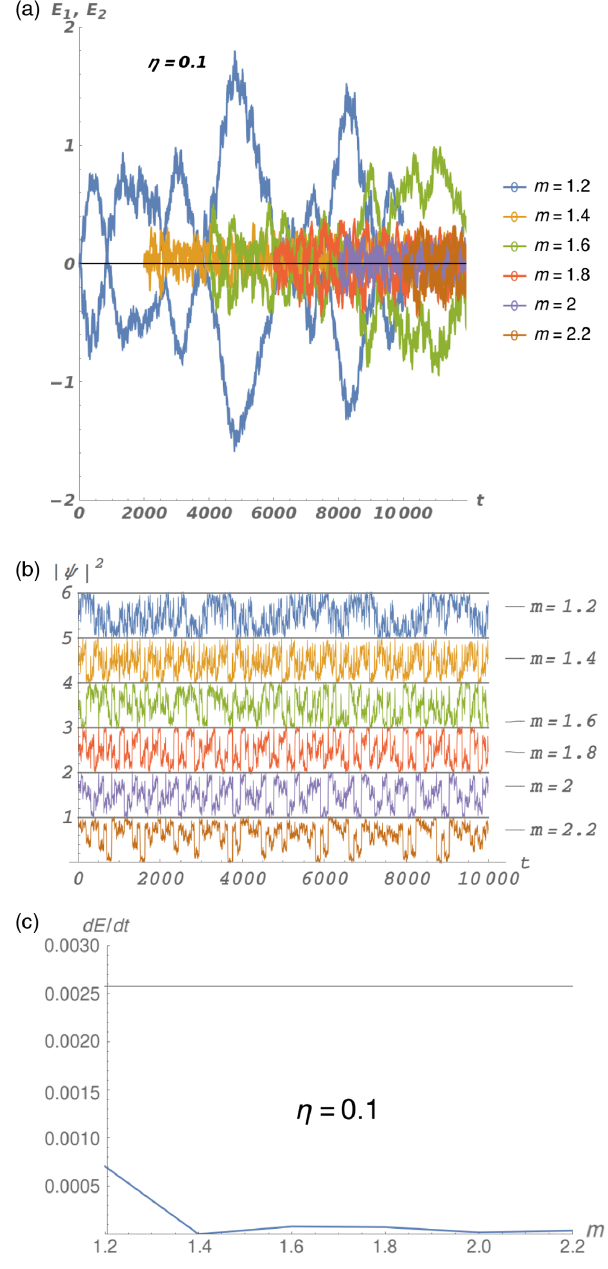
FIG. 15. Work and fidelity in the weak-drive regime. (a) Energy transfers for η ¼ 0 . 1 . (b) Fidelities of the initial state, an instantaneous eigenstate of H ð 0 Þ , and the instantaneous eigen- states of H ð t Þ . The initial phases for these plots are ϕ π = 10 ; ϕ 0 . (c) Power pump averaged for t < 2000 as 1 ¼ 2 ¼ a function of gap parameter m